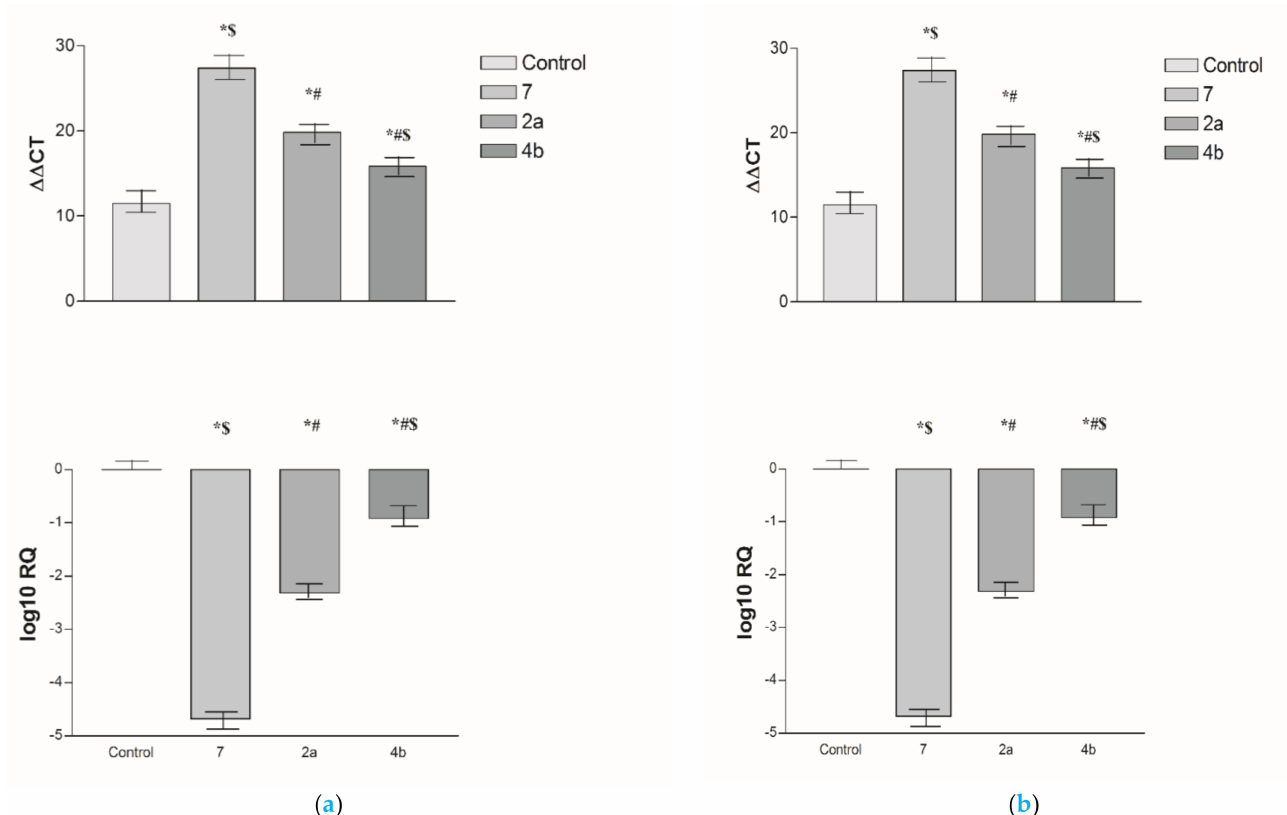
Figure 8. Effects of 7 , 2a and 4b on the VEGF gene expression level (( a ) HepG2 and ( b ) MCF-7). All therapies were provided for 3 successive days. Results are given as mean ± S.E.M. The difference in ∆∆ CT readings among all of the treated groups. Average fold decrease of VEGF gene expression on a log scale. * p ≤ 0.05 vs Control, # p ≤ 0.05 vs 7, $ p ≤ 0.05 vs 2a